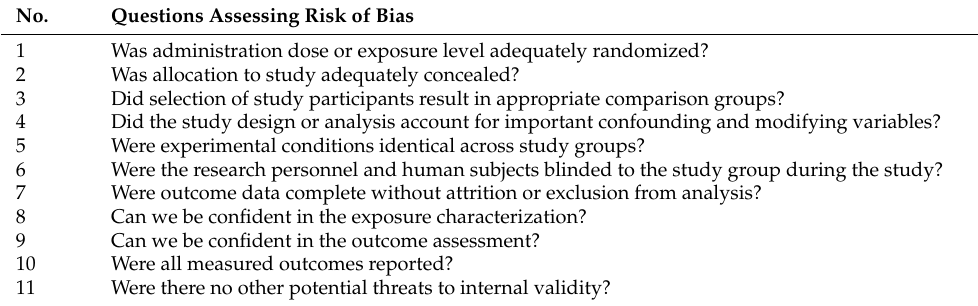
Table 4. OHAT Risk of Bias